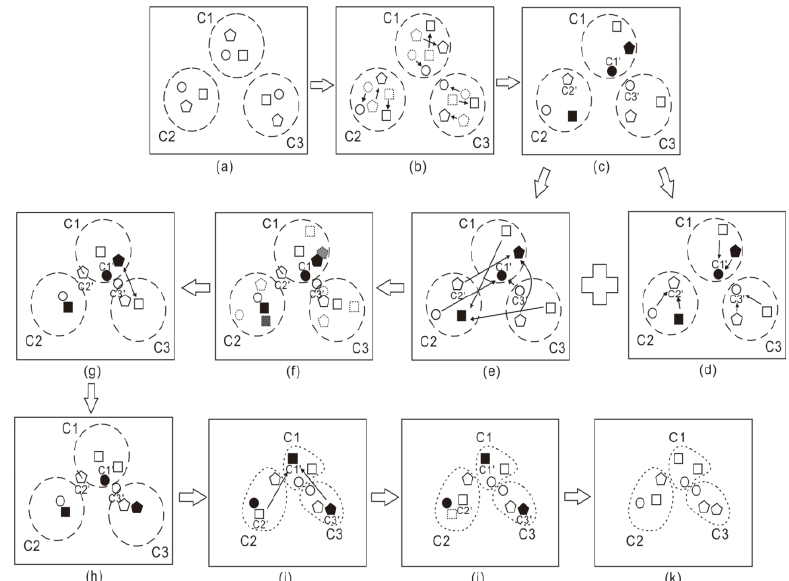
Figure 6. POA multiple-step process [26].